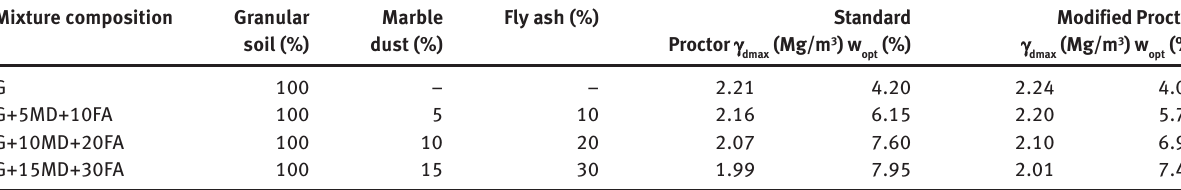
Table 3 Mixtures compositions and compaction characteristics. G, granular soil; MD, marble dust; FA, fly